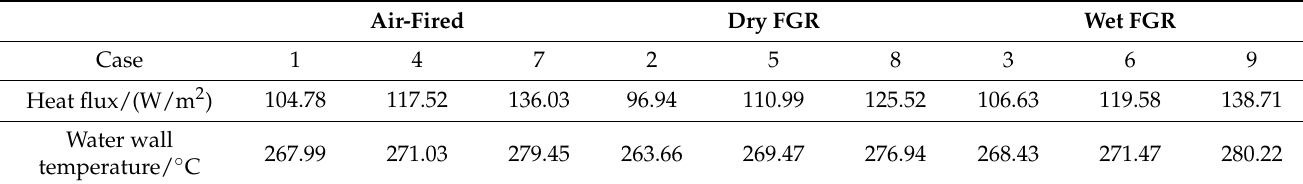
Table 4. Comparison of the average heat flux and temperature of the front wall in different cases.